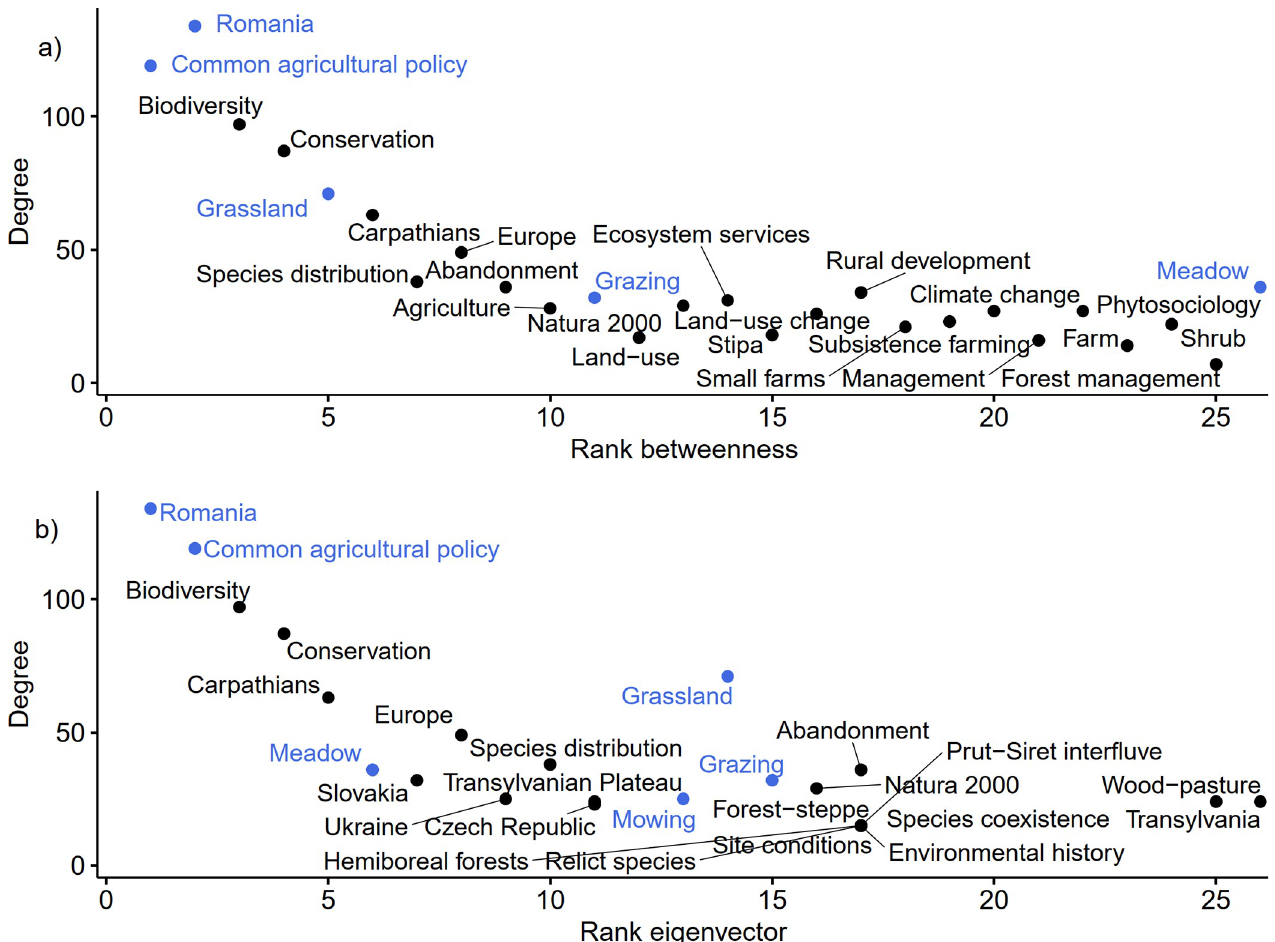
Fig 9. Top 25 keywords by degree and eigenvector used in publications about Romania’s grasslands. Keywords in blue were used for data collection.